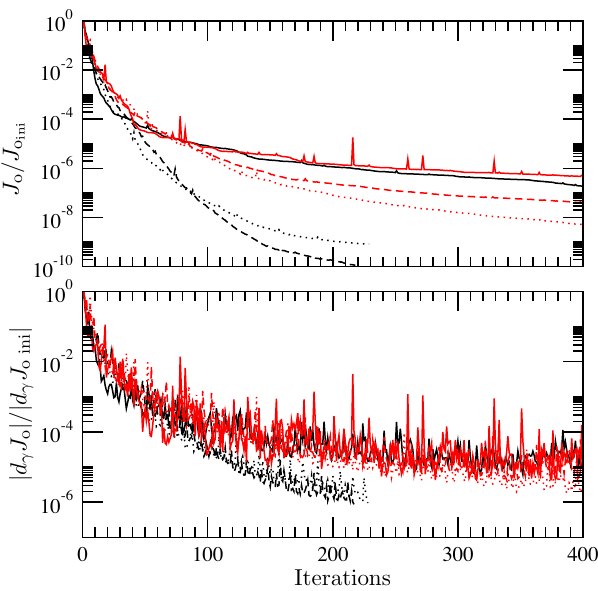
Fig. 5. Evolution as a function of the number of iterations of (top) the cost function relative to the initial cost function and (bottom) the norm of the gradient vector relative to the initial gradient norm for the Robin (black curves) and Control (red curves) inverse methods for the inversion of β (solid curve), E η ( x,y ) (dashed curve) and E η ( x,y,z ) (dotted curve).